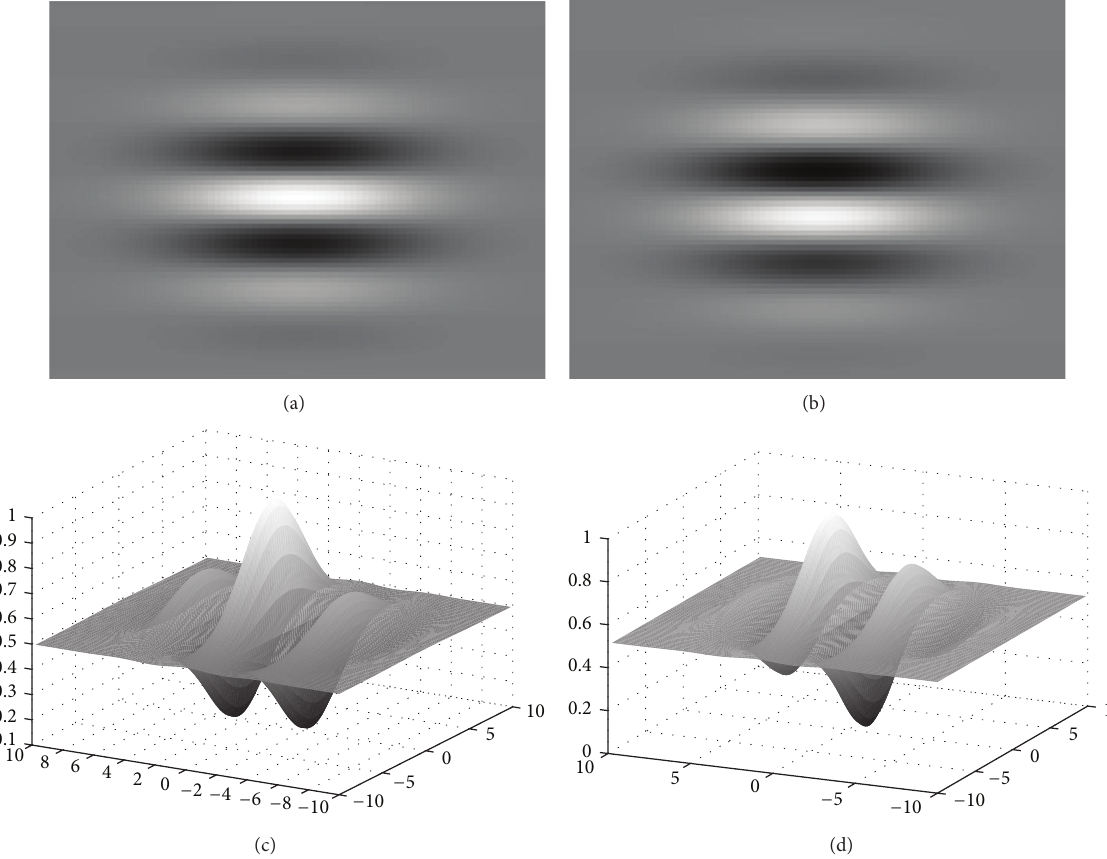
Figure 2: A two-dimensional Gabor wavelet; ((a), (c)) real part, ((b), (d)) imaginary